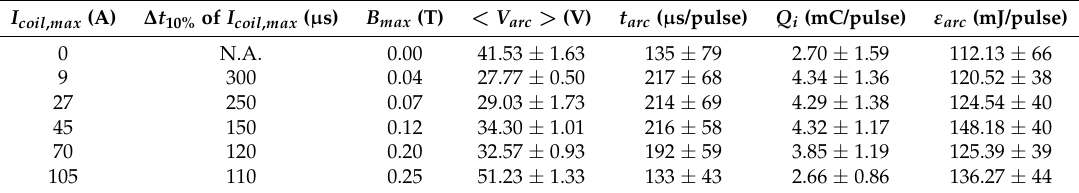
Figure 7. Measured arc current and magnet current for B = 0.25 T and B = 0.04 T case. Blue and green dotted lines represents the time duration for I coil variation within 10% at corresponding B-field. Table 1. Measured arc voltage < V arc > , arc duration, total charge and arc energy per pulse versus maximum magnetic coil current I coil , max , shown results are for I arc , max = 40